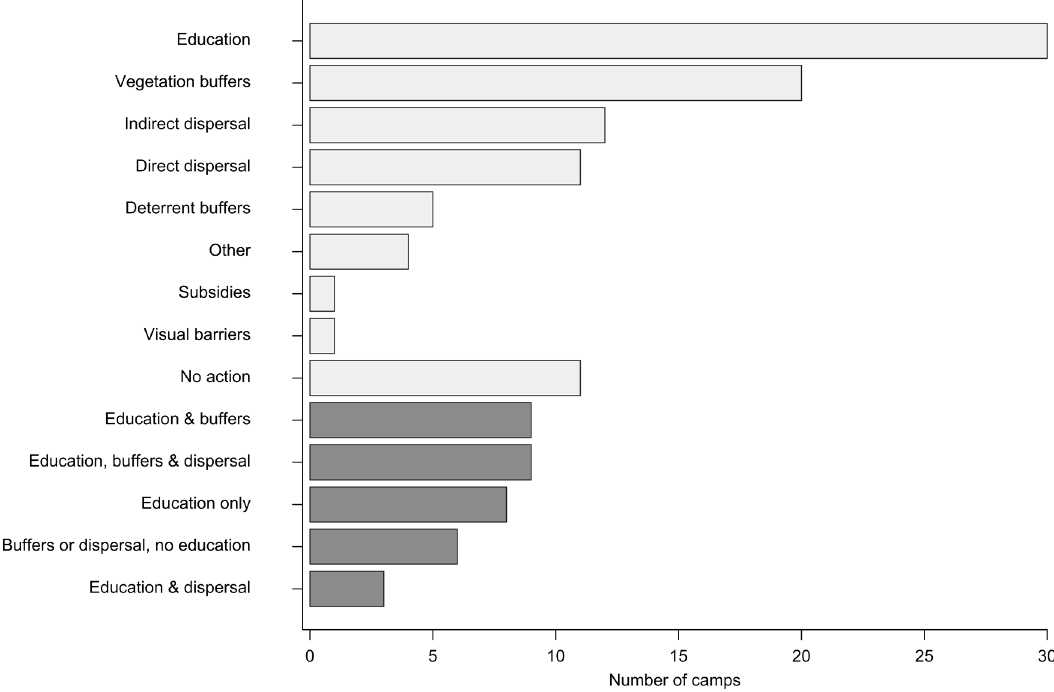
Figure 3. Frequency of management actions implemented at flying-fox camps in the last five years. Light grey bars indicate where that action was undertaken at any camp, while dark grey bars show specifically where that action was used in isolation (e.g., “Education only”) or combination (e.g., “Education and dispersal”). For these darker bars ‘buffers’ includes vegetation removal and deterrents, and ‘dispersal’ includes direct and indirect methods. A description of each management technique is provided (File S2).